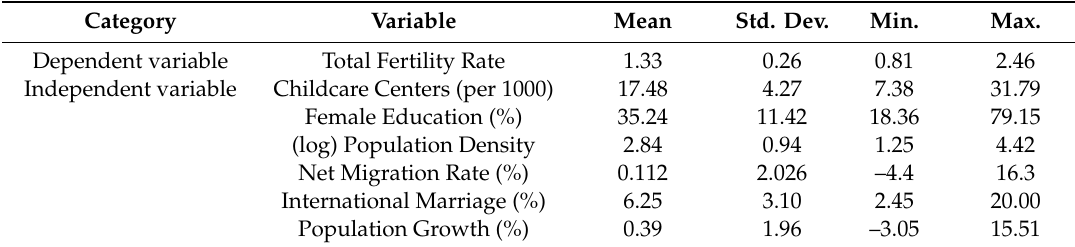
Table 1. Descriptive statistics (in 2015).